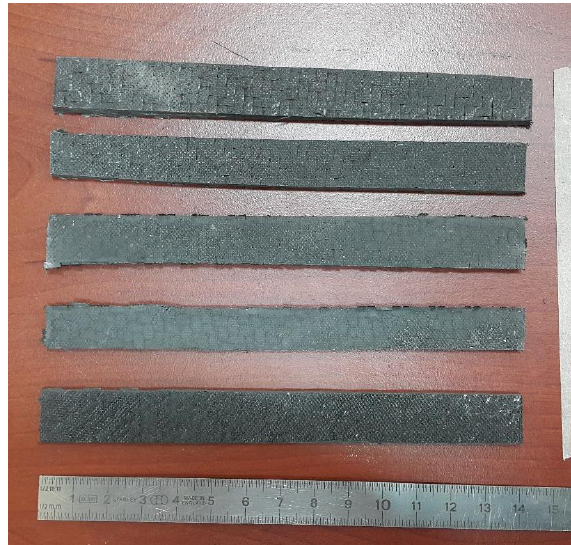
Figure 3. CNTRC composite samples.